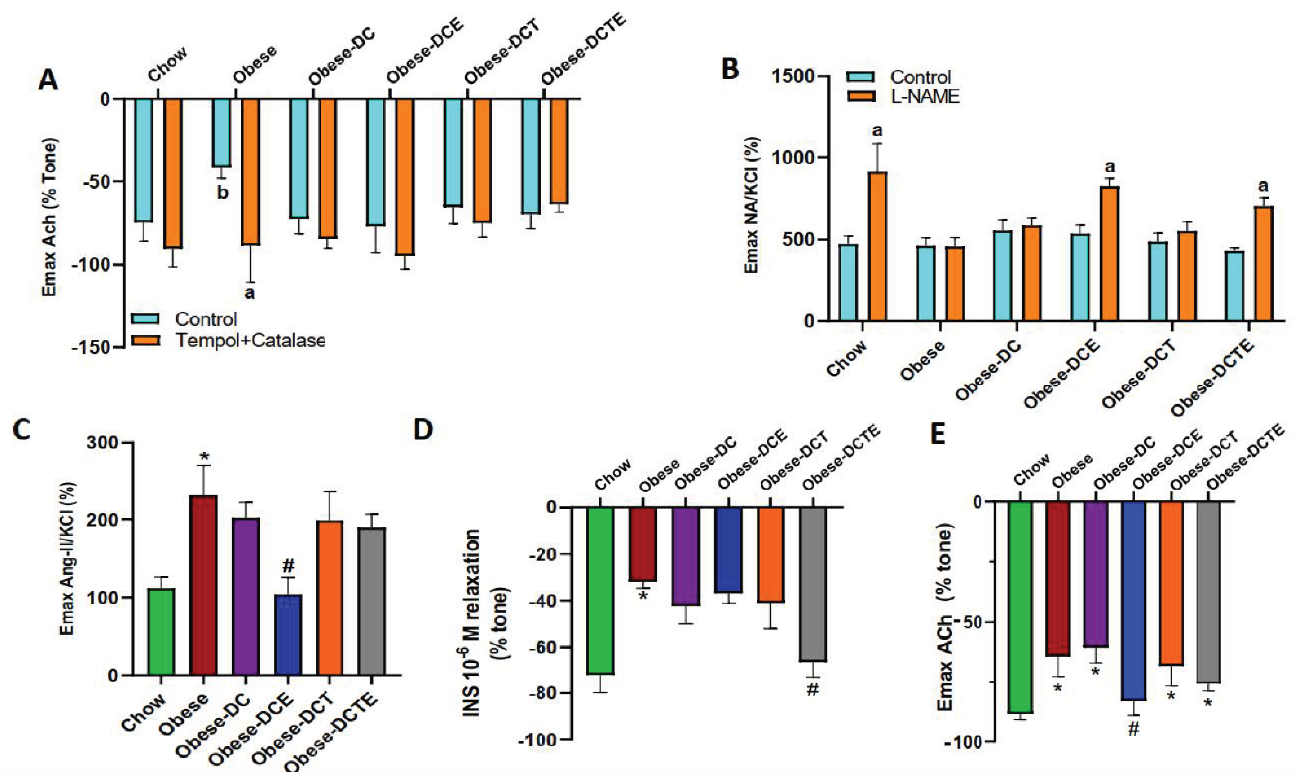
Figure 8. Maximum vascular response of abdominal aortic rings to accumulative concentrations of angiotensin-II (10 − 11 to 10 − 6 M) ( A ); ( B ) Dose-response curve of aorta segments to accumulative concentrations of norepinephrine (10 − 9 to 10 − 4 M) in the presence/absence of the inhibitor L-NAME ( B ); ( C ) Maximum vascular response of thoracic aortic rings to accumulative concentrations of acetylcholine (10 − 9 to 10 − 4 M) in the presence/absence of Tempol+Catalase; ( D ) Vascular response of aorta segments to a single dose of insulin (10 − 6 ). ( E ) Vascular response of superior mesenteric artery to accumulative concentrations of acetylcholine (10 − 9 to 10 − 4 M). Chow = mice fed a standard diet for 25 weeks; Obese = mice fed a high fat (60% kcal from fat)/high sucrose diet for 25 weeks; DC = mice fed a high fat (60% kcal from fat)/high sucrose diet for 23 weeks and switched to a diet with lower caloric intake (25% kcal from fat) for two weeks; DCE = mice fed a high fat (60% kcal from fat)/high sucrose diet for 23 weeks and switched to a diet with lower caloric intake (25% kcal from fat) supplemented with CSAT+ ® for two weeks; DCT = mice fed a high fat (60% kcal from fat)/high sucrose diet for 23 weeks and switched to a diet with lower caloric intake (25% kcal from fat) and subjected to aerobic training for two weeks; DCTE = mice fed a high fat (60% kcal from fat)/high sucrose diet for 23 weeks and switched to a diet with lower caloric intake (25% kcal from fat) supplemented with CSAT+ ® and subjected to aerobic training for two weeks. Values are represented as mean ± SEM; n = 8–10 mice/group. * p < 0.05 vs. chow; # p < 0.05 vs. obese. a p < 0.05 vs. their respective control; b p < 0.01 vs. control chow.